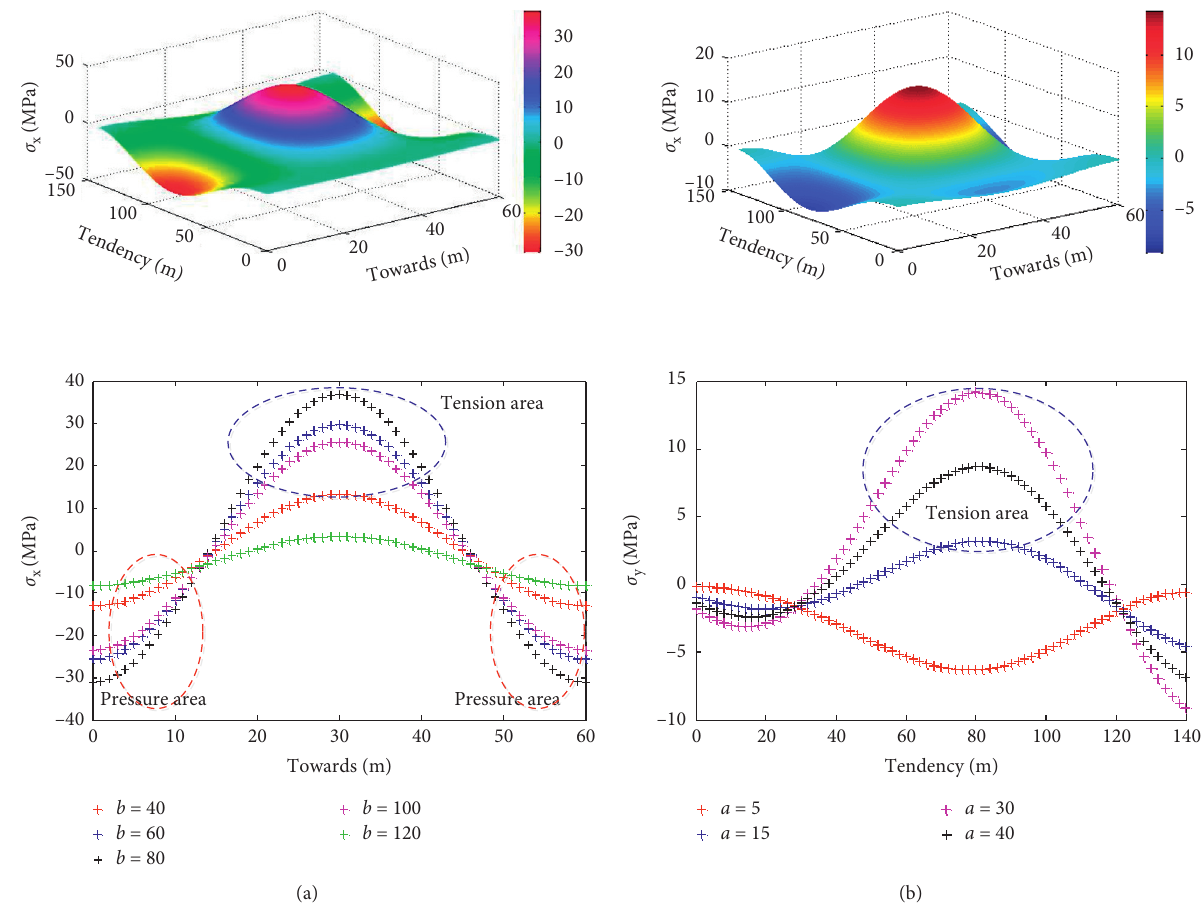
Figure 2: Characteristics of σ x and σ y in the bottom floor of the thin plate. (a) σ x . (b) σ y